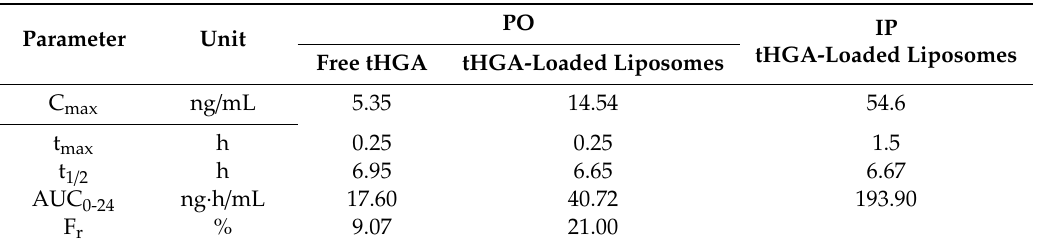
Table 3. Pharmacokinetics parameters and relative oral bioavailability of tHGA following PO administration of the free and liposomal formulation of tHGA and IP administration of tHGA at the dose of 20 mg/kg.